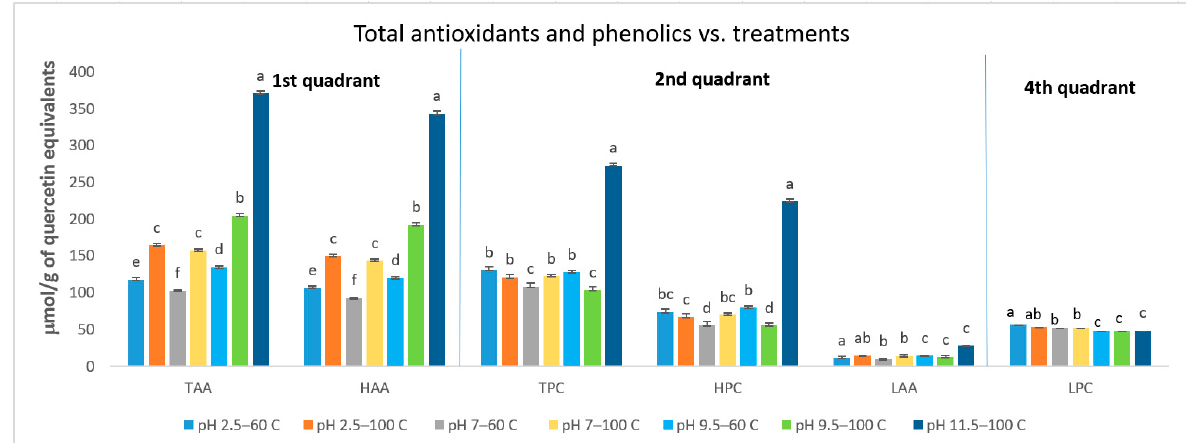
Figure 2. Bar charts showing the difference in phenolics and antioxidants following ANOVA for the components segregated per quadrant in the PCA biplot. Hydrophilic antioxidant activity (HAA), lipophilic antioxidant activity (LAA), total antioxidant (TAA), hydrophilic phenolic content (HPC), lipophilic phenolic content (LPC), and total phenolic content (TPC). The antioxidant activities are reported as μ mol/g of Trolox equivalents. The phenolics content is represented as μ mol/g of quercetin equivalents. Values accompanied by the same letters are not significantly different ( p < 0.05), Fisher’s LSD test.